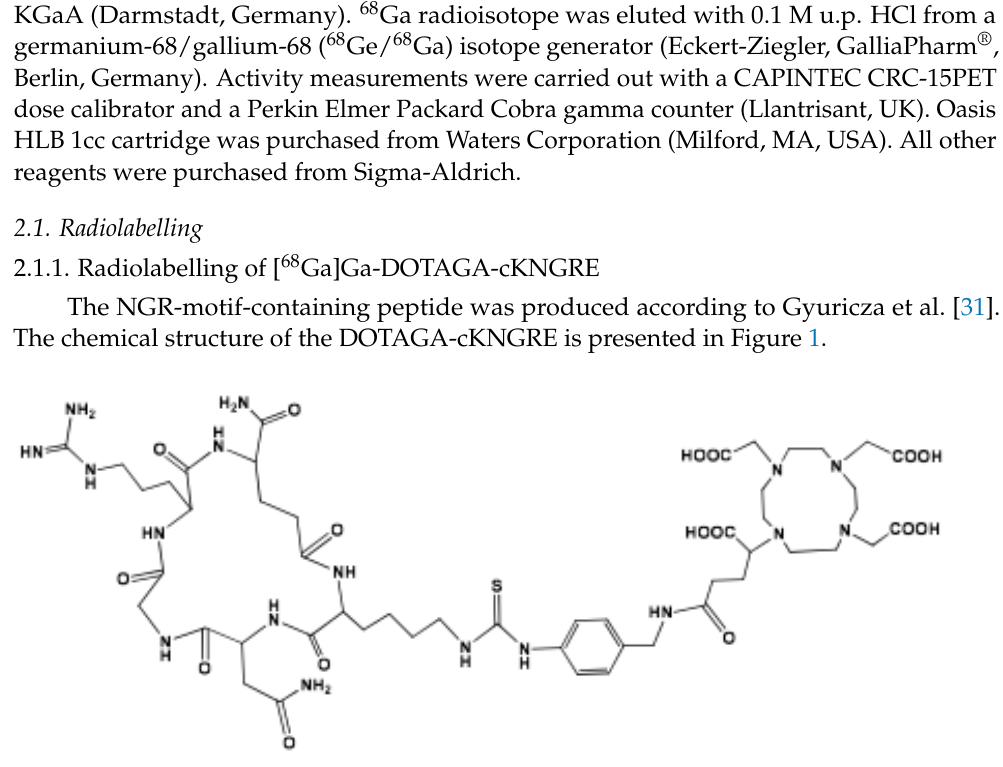
Figure 1. Chemical structure of